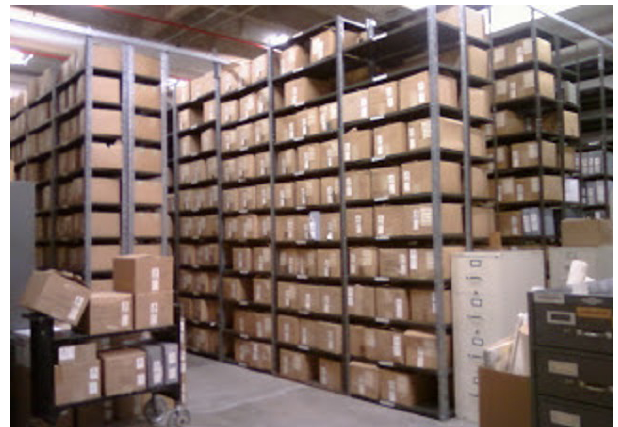
Figure 8. Photo of a subset of the six rows of international hard- copy holdings held in the basement of NCEI that were fully indexed and a small subset of which was imaged in 2012. The inventory and imaged subset can be found at ftp://ftp.ncdc.noaa.gov/pub/data/